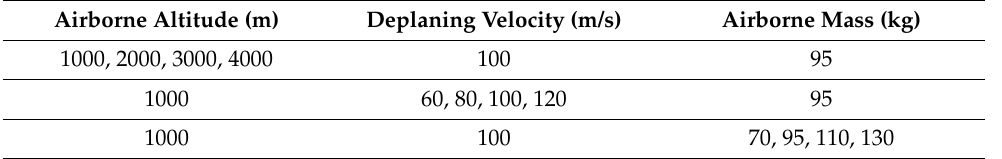
Table 2. Airborne conditions.